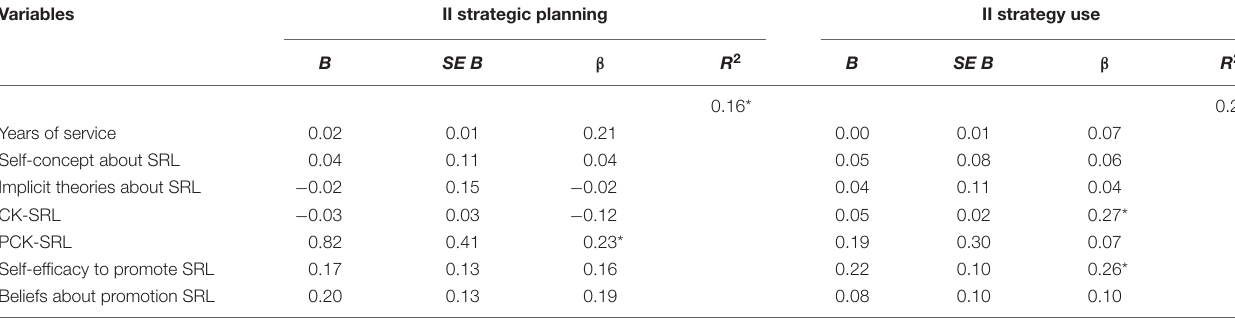
TABLE 4 | Regression analyses for the intention to implement specific aspects of SRL in class (I).